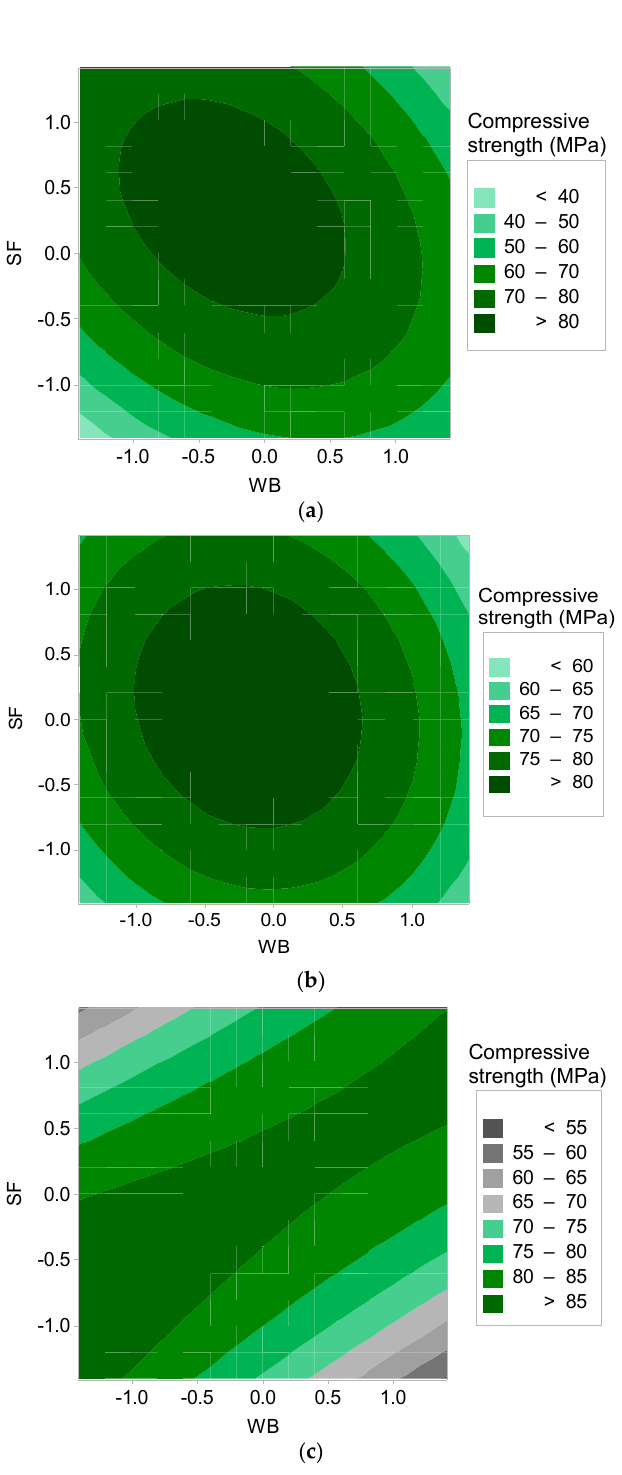
Figure 13. Contour plots for combined effect of WB and SF (%) on compressive strength: ( a ) 7-day plot; ( b ) 28-day plot; ( c ) 56-day